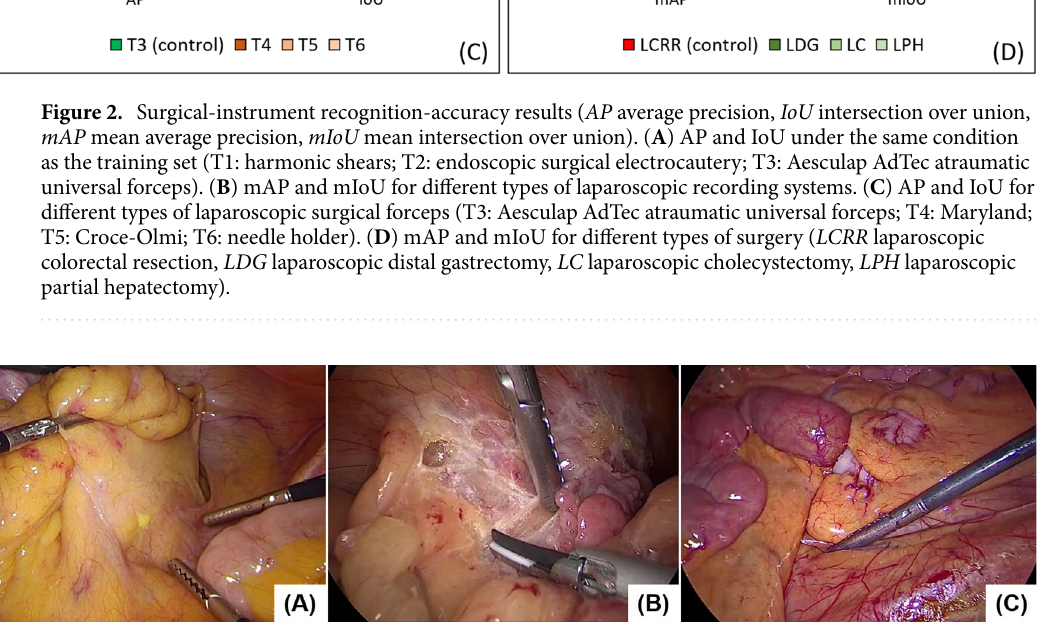
Figure 3. Representative images recorded by each laparoscopic recording system. ( A ) Endoeye laparoscope (Olympus Co., Ltd., Tokyo, Japan) and Visera Elite II system (Olympus Co., Ltd, Tokyo, Japan). ( B ) 1488 HD 3-Chip camera system (Stryker Corp., Kalamazoo, MI, USA). ( C ) Image 1 S camera system (Karl Storz SE & Co., KG, Tuttlingen,